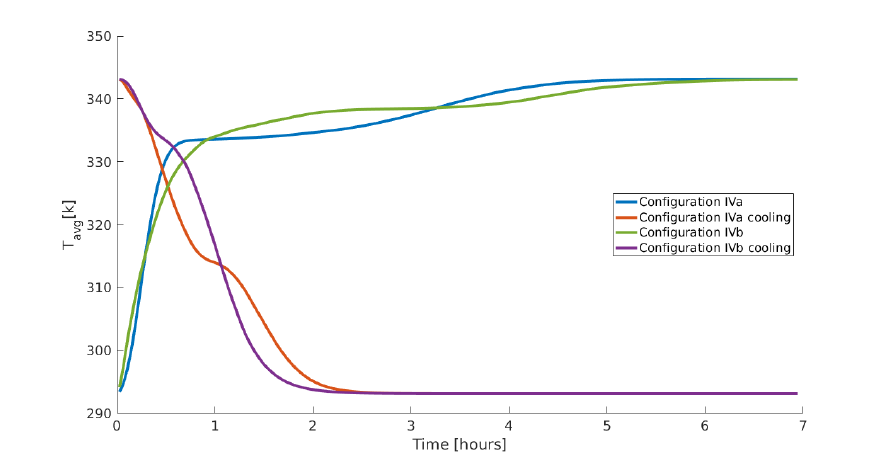
Figure 9. Average temperature of PCM particles.